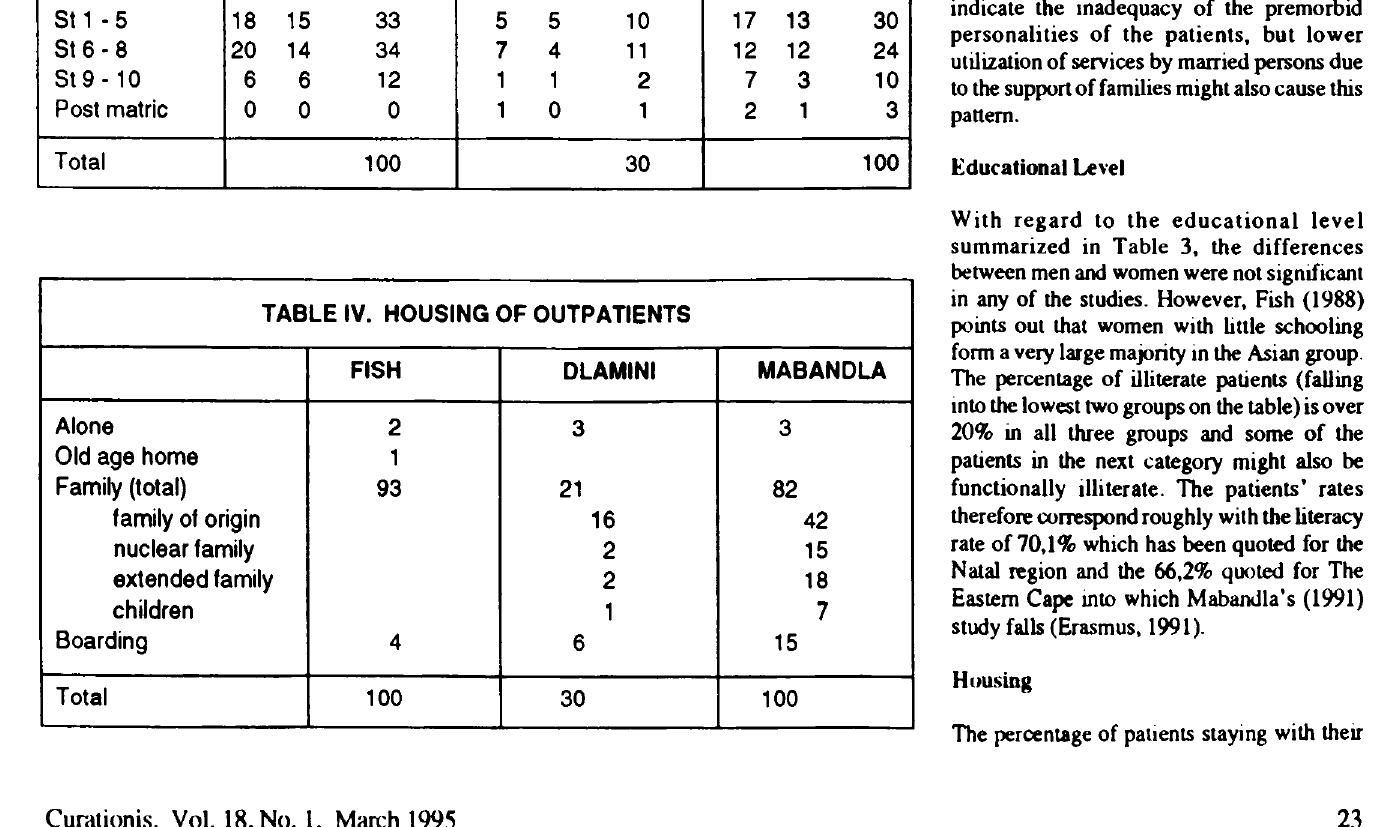
TABLE IV. HOUSING OF